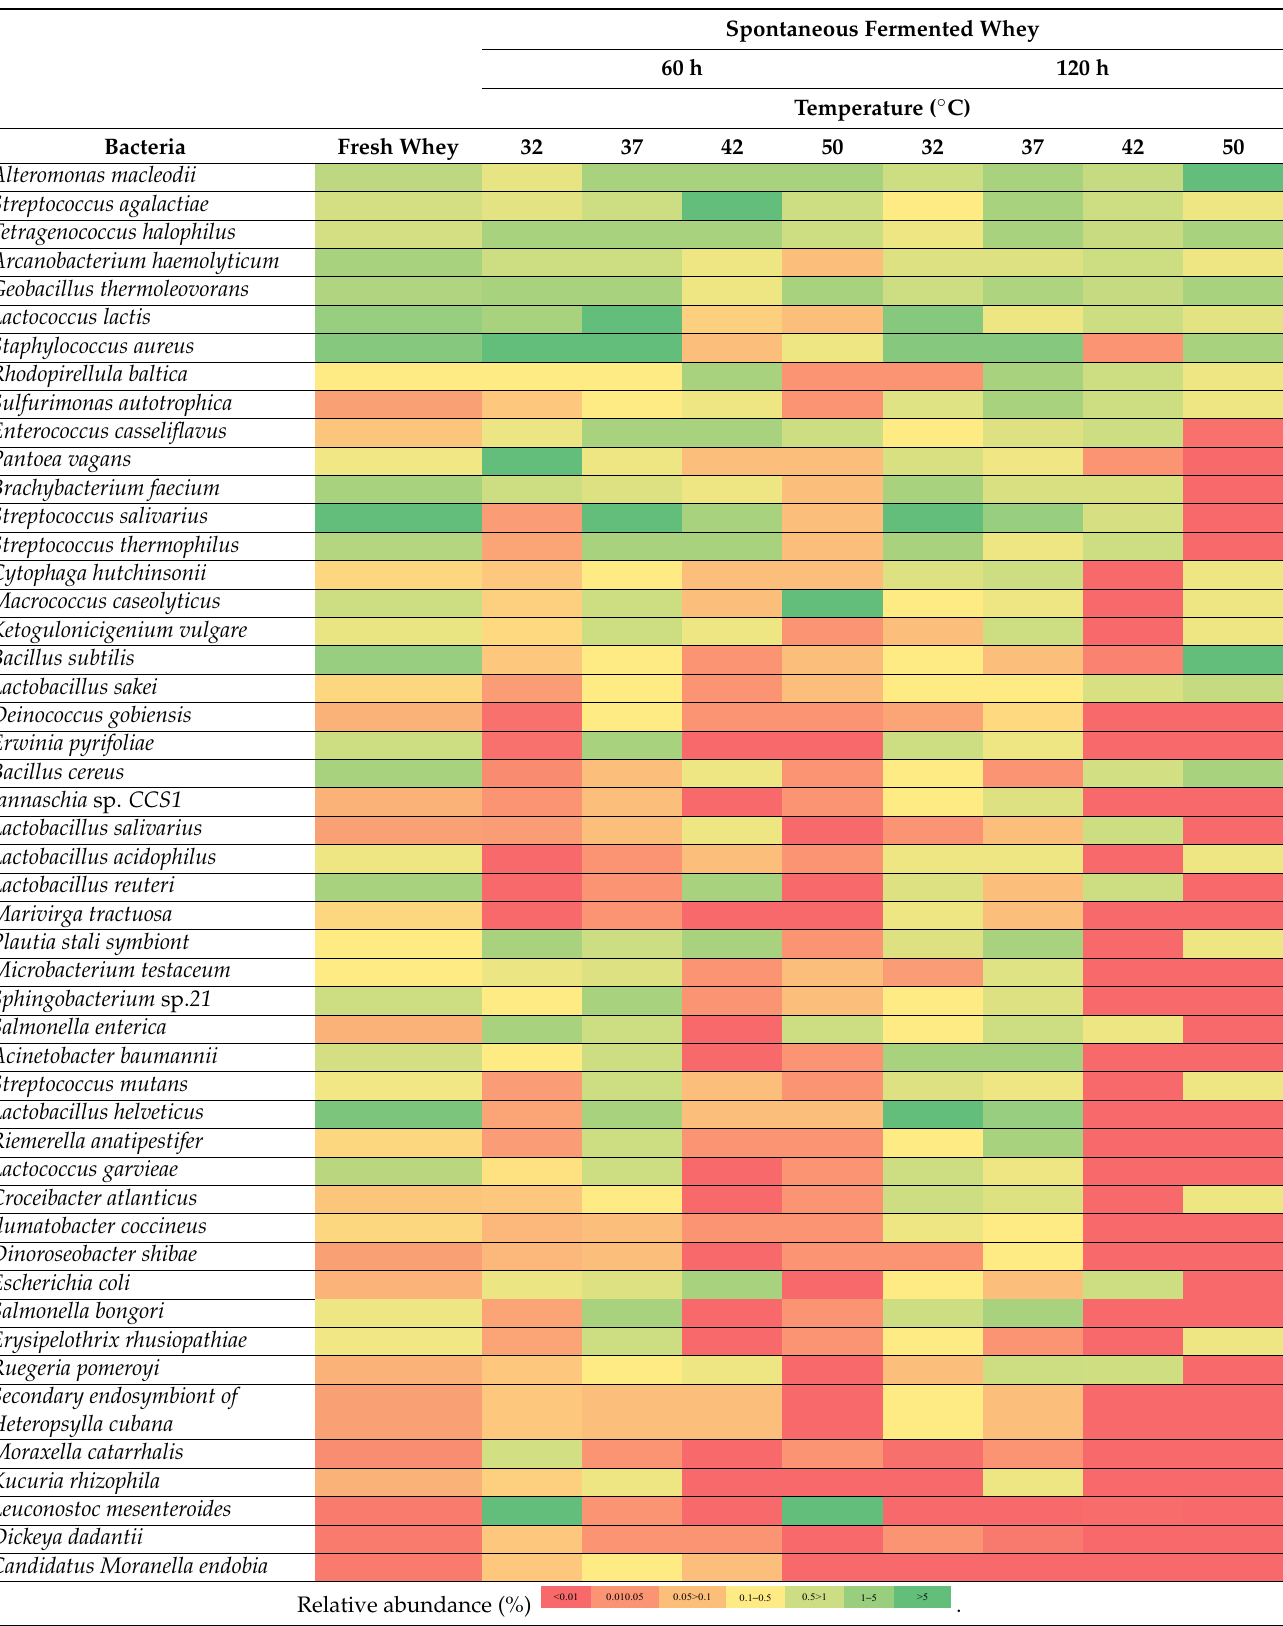
Table 4. Heatmap displaying the abundance of predominant bacterial species during whey fermenta- tion for 60 and 120 h at different